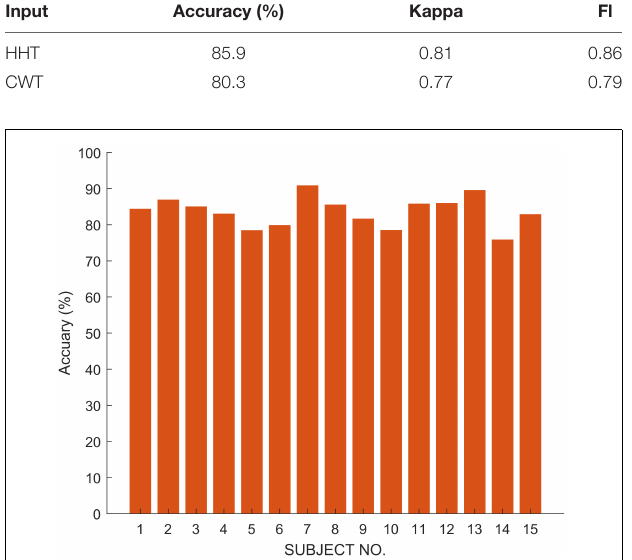
TABLE 3 | The performance of MSDFN using HHT and CWT.